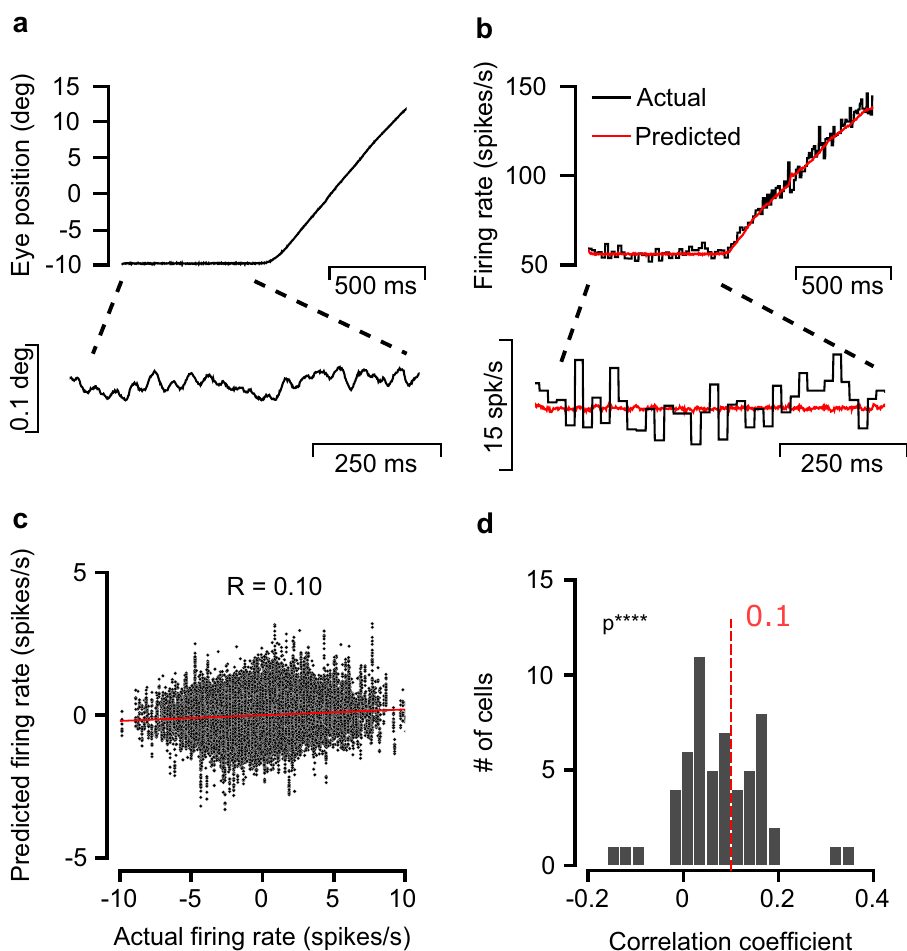
Fig. 1 Eye variability during fi xation is correlated with motoneuron activity. a Single recorded horizontal eye trajectory consisting of fi xation followed by smooth pursuit. Lower panel, fi xational period expanded and smoothed with a Savitzky-golay fi lter of order 3 (21 ms window, data sampled at 1 KHz). b Actual and predicted fi ring rate of a single OMN during the trajectory shown in ( a ). Lower panel, zoom in on fi xational segment. Note that the actual fi ring rate is much more variable than the predicted rate. The predicted fi ring rate based on the spikes was obtained by fi tting the parameters k , r , m , E T in eq. (2) to minimize a mean squared error loss function, eq. (3) (Methods). c Predicted vs. actual fi ring rate of a single cell during fi xation (mean rate subtracted in both axes). Each point represent the fi ring rate at a single trial at speci fi c time. Red line: result of linear regression analysis, correlation coef fi cient: R = 0.10. d Distribution of correlation coef fi cients between actual and predicted rate, collected from 57 cells in two monkeys. One sided t test, p = 3 × 10 − 9